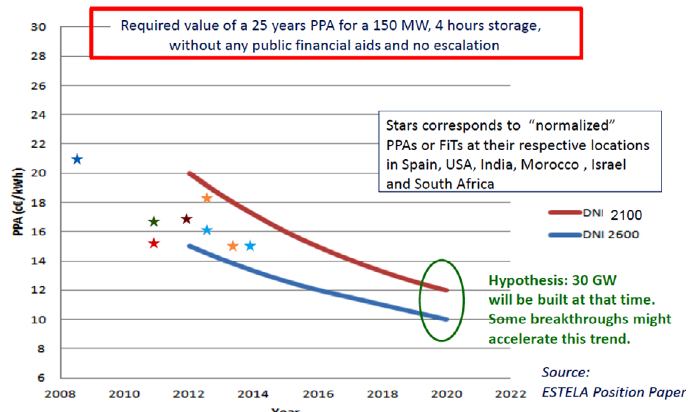
Fig. 4. Cost reduction: the view from the European Industry (source: ESTELA).